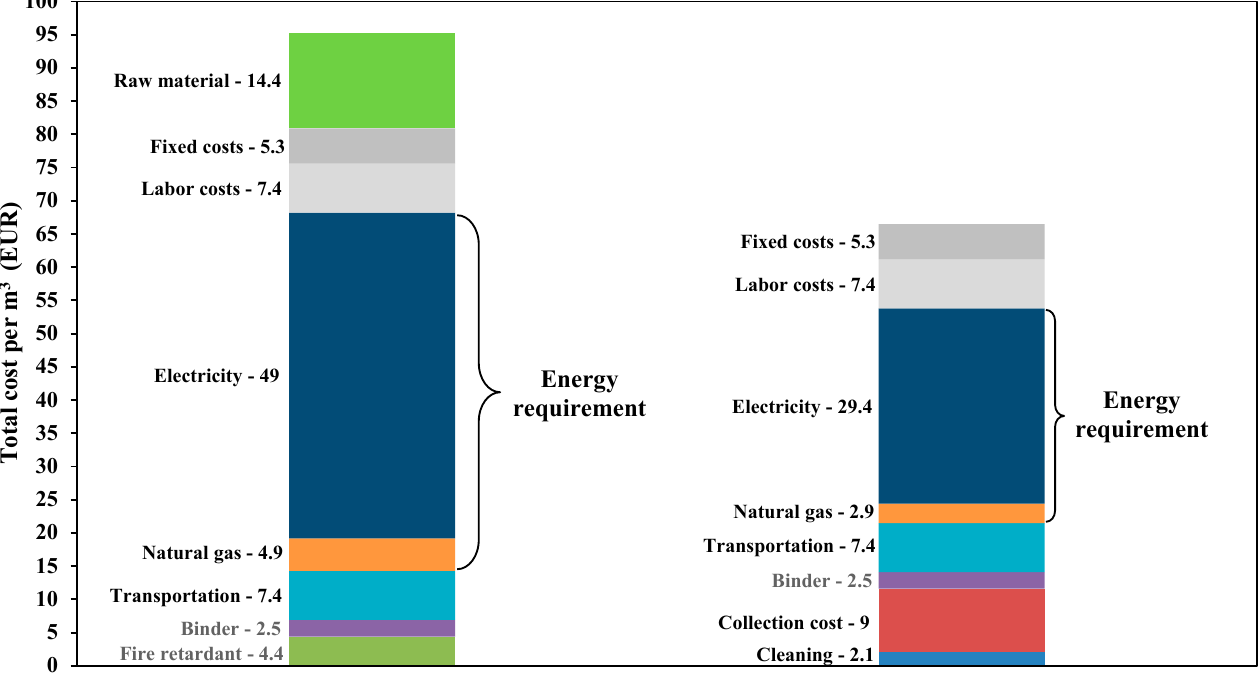
Figure 6. A simplified cost analysis of the insulation boards from seagrass leaves and wood fibers. Apart from the economical profitability, a comparison of seagrass with other natural fibers (and synthetic materials) shows the advantages of seagrass materials (Table